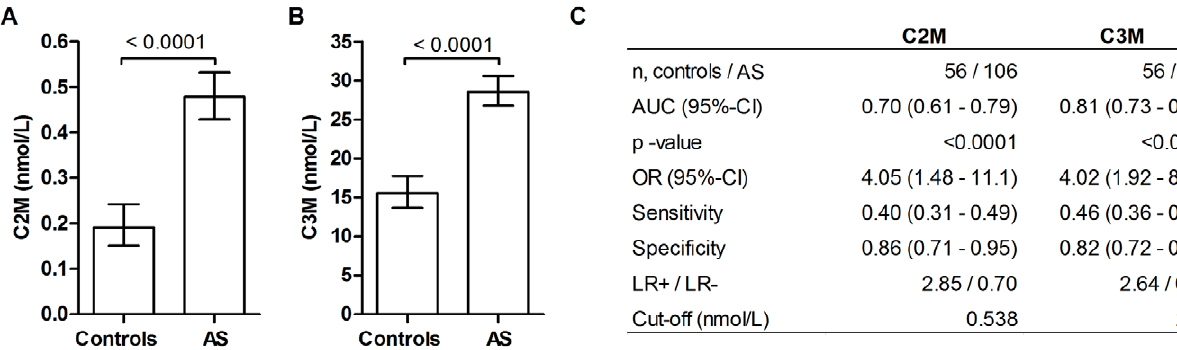
Figure 2. The level of the cartilage degradation and connective tissue inflammation in AS patients (n=103) and controls (n=56). A) Cartilage degradation measured by C2M in serum. B) Connective tissue degradation measured by C3M in serum C) The diagnostic utility depicted as area under the curve (AUC), odds ratio (OR), sensitivity, specificity and likelihood ratio (LR). Cut-off values were set as 1 SD above the mean of the healthy controls. Comparison of AS patients and controls was performed on log transformed data with student’s t-test. Results are shown as geometric mean with 95% CI. Diagnostic utility was calculated by a contingency table applying Fisher’s exact test.